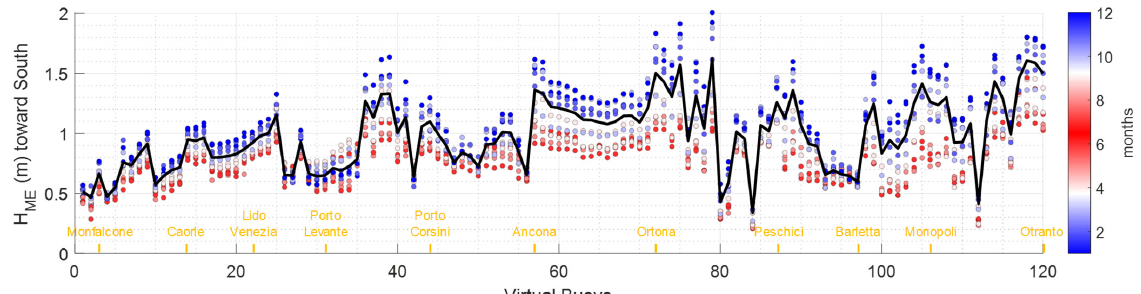
Figure 8. H ME (black line) directed toward south, computed at the 120 virtual buoys along the Italian Adriatic coast relative to the historic run (HR). Colored dots are the monthly H ME at the 120 points and some locations are highlighted to increase the figure readability.